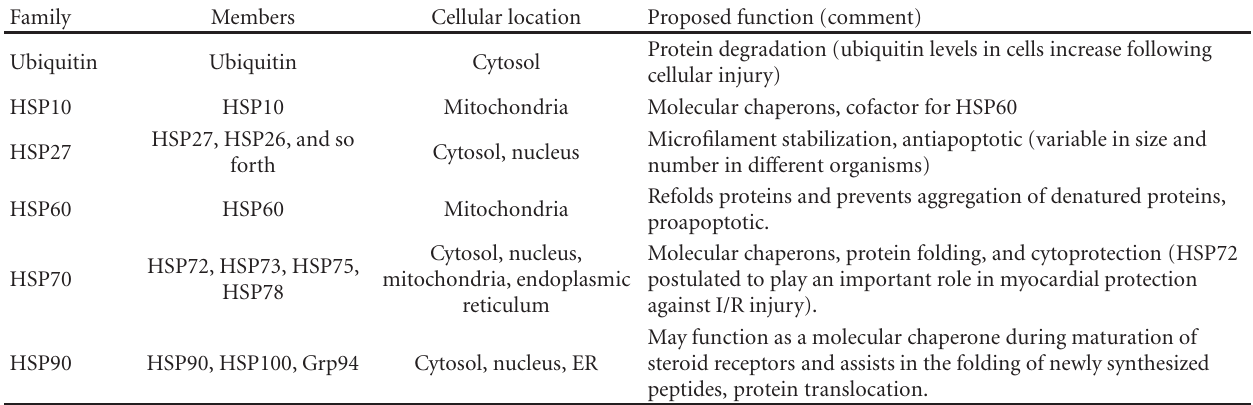
Table 1: Cellular location and function of selected heat shock proteins (HSPs) [22, 23, 32, 37].